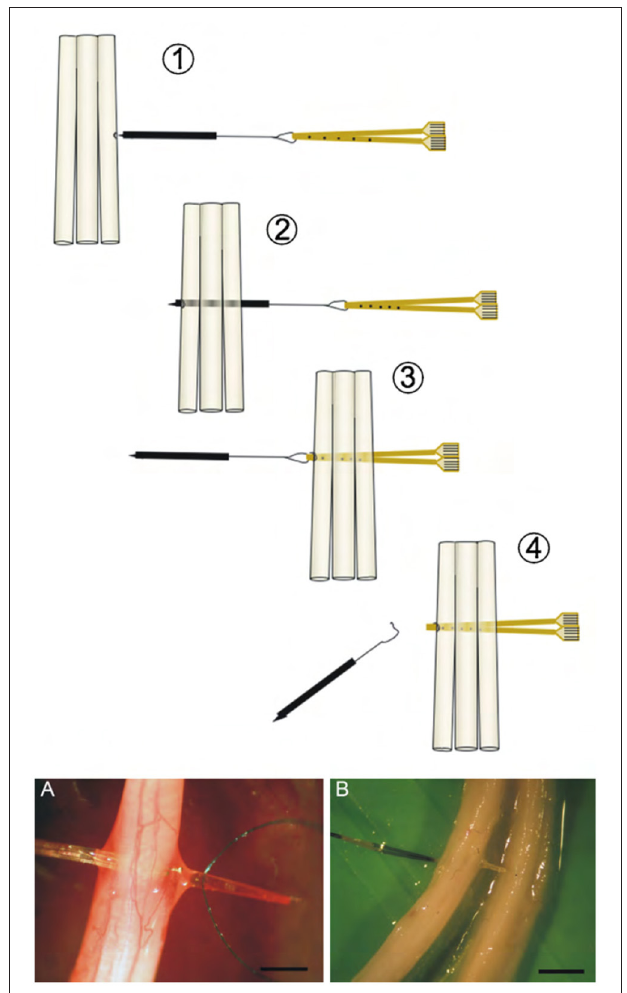
FIGURE 4 | (Above) Schematic view of the implementation of the double folded TIME electrode through three fascicles. (Below) Photographs of a TIME electrode in situ . Scale bar is 5 mm. Reproduced with permission from Boretius et al.